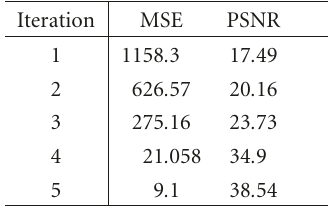
Table 3: Reconstructed image quality using typical turbo code over AWGN